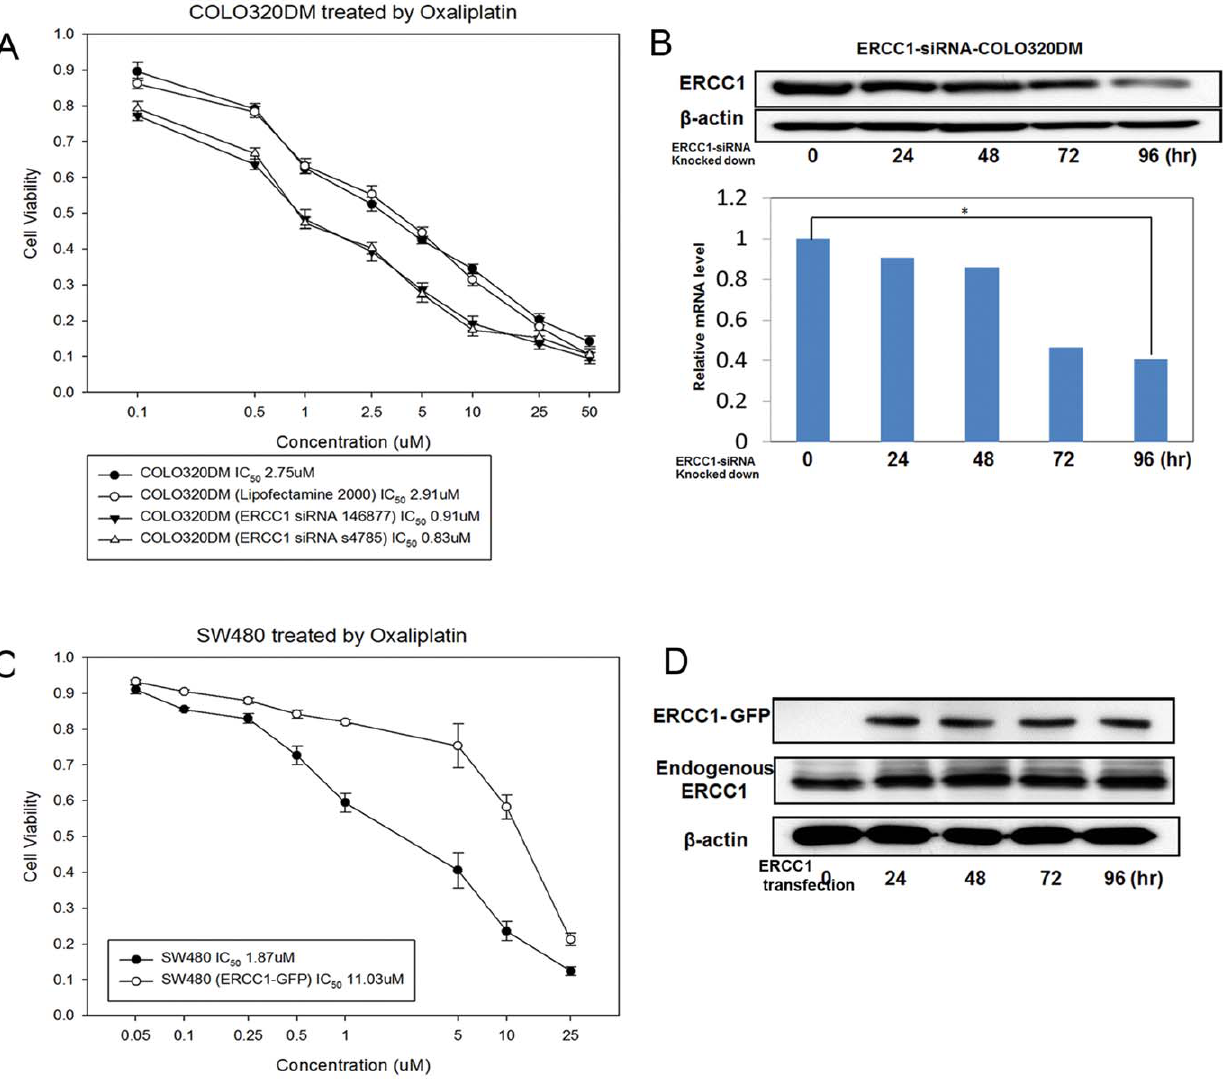
Figure 5. Validating ERCC1 as the predictor of oxaliplatin sensitivity in CRC cells. (A) ERCC1-knocked-down COLO320DM cells were more sensitive to oxaliplatin than parental COLO320DM cells, as demonstrated by MTT assay. (B) Protein and mRNA levels of ERCC1 were downregulated when COLO320DM cells were knocked-down by ERCC1 siRNA. *: p , 0.05 (C) ERCC1-GFP-SW480 G12V cells were more resistant to oxaliplatin than parental SW480 G12V cells. (D) Ectopic ERCC1 was upregulated after SW480 G12V cells were transfected by the ERCC1-GFP expression vector.